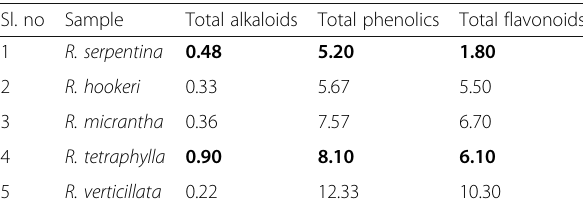
Table 4 Estimation of major phytochemicals in various Rauvolfia species